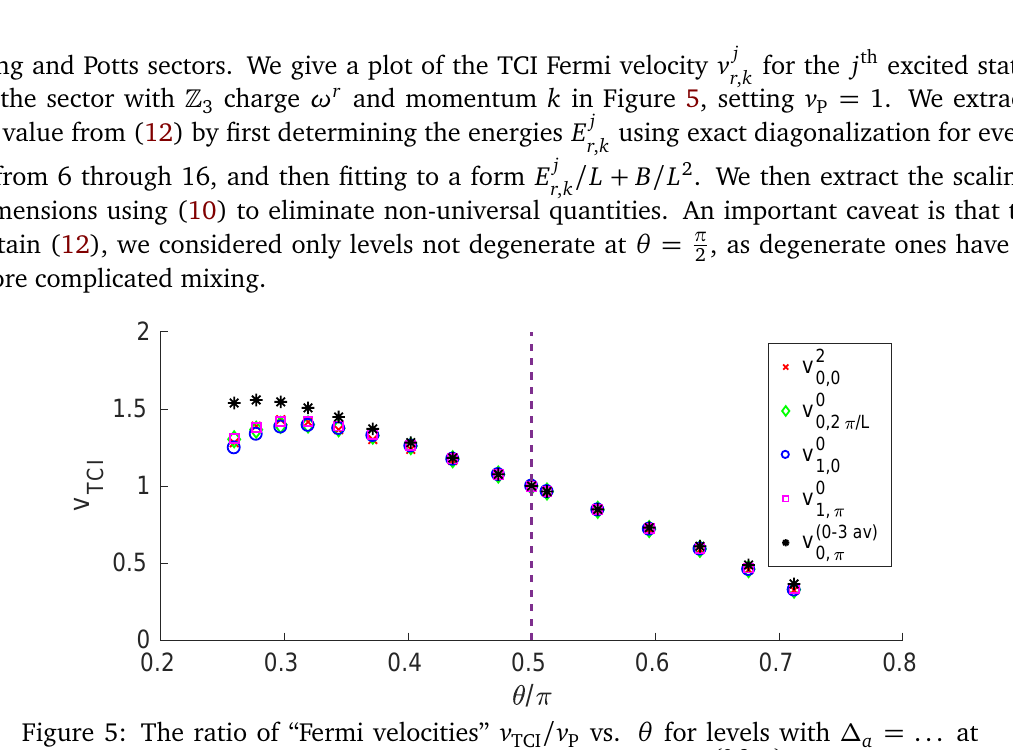
Figure 5: The ratio of “Fermi velocities” v θ = π , determined from (12) as explained in the text. The v (0-3 av) 2 the four lowest levels in this sector, which are degenerate at the integrable